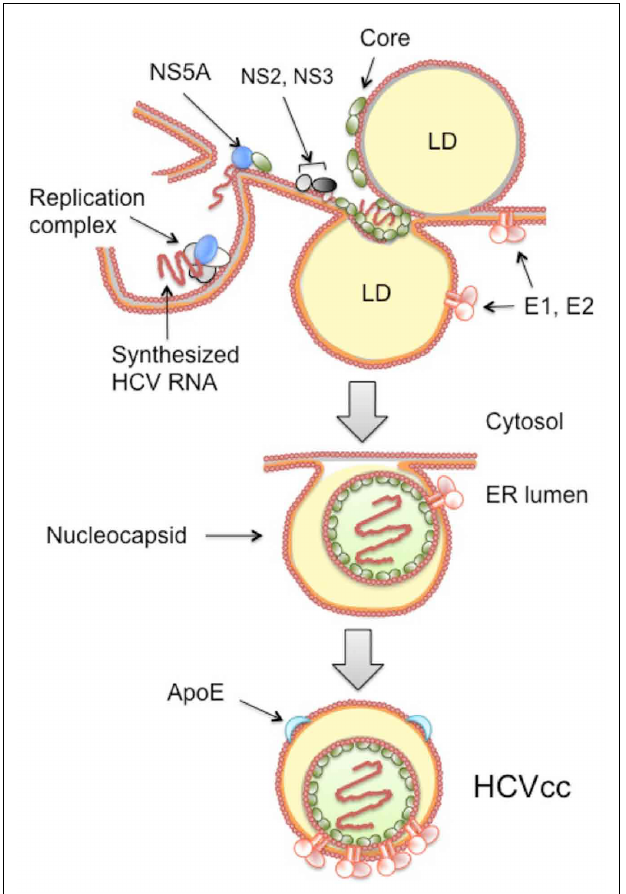
FIGURE 2 | Proposed model for assembly of HCV particles. After accumulation of synthesized genome RNA and the viral proteins, the HCV particles are assembled in an ER-related compartment in close connection with theVLDL pathway.The viral replication complex, which is composed of NS3–NS5B and host factors, is a specialized structure protected by cellular membrane. Newly synthesized viral RNAs are recruited to surfaces of lipid droplet (LD), where ER membrane is associated, possibly via interaction between NS5A and Core.Thus, the RNAs enable to associate with Core, thereby proceeding encapsidation and nucleocapsid formation.The nucleocapsid is presumably inserted into the lipid core of the luminal LD and buds into the ER lumen with incorporation of E1 and E2. HCV–lipoprotein particle formed is then released from the